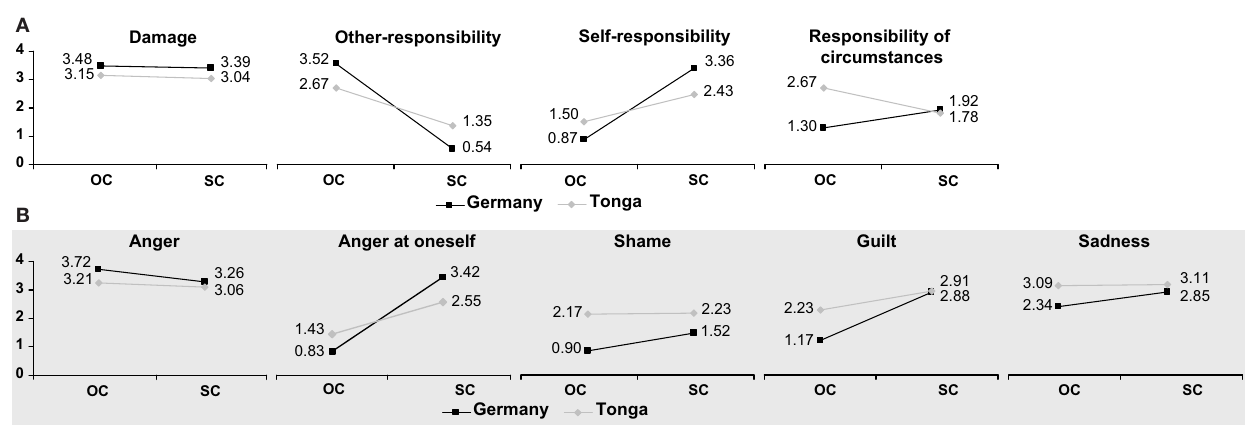
in Tonga than in Germany (as were differences in